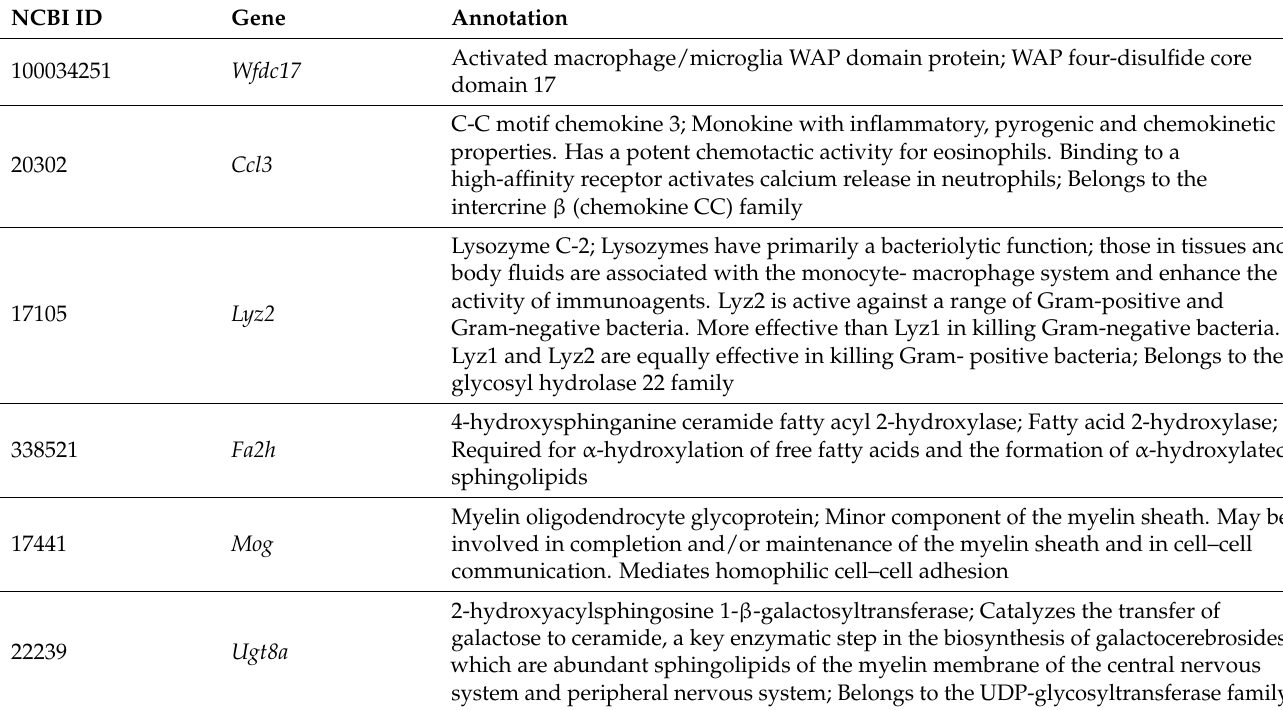
Table 1. NCBI IDs and gene function annotation using String